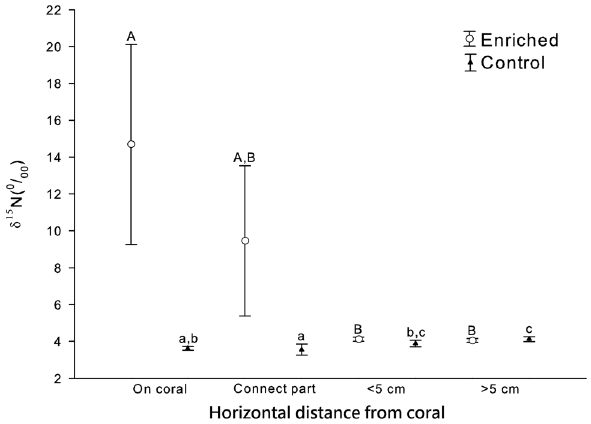
Figure 6. Stable nitrogen isotope composition δ 15 N of Terpios hoshinota grown on and at different positions in control and enriched ( 15 N) corals. Error bars indicate 95% c.i. Different letters indicate the significant difference (Upper letter: Enrich group; Lower letter: Control